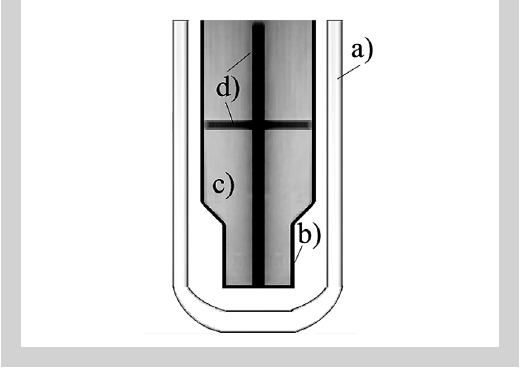
Figure 1: Schematic representation of experimental setup: a) MRI cell, b) sample holder (glass tube), c) sample, d) projection of the “cutting”